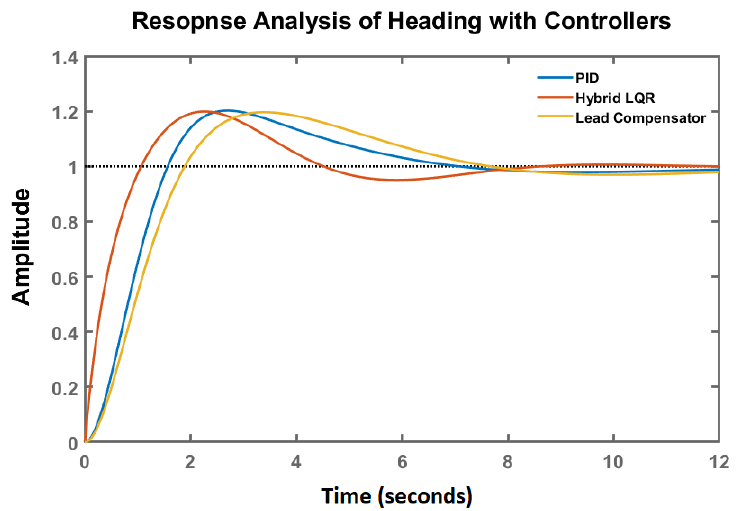
Figure 11. Analysis of heading control system with